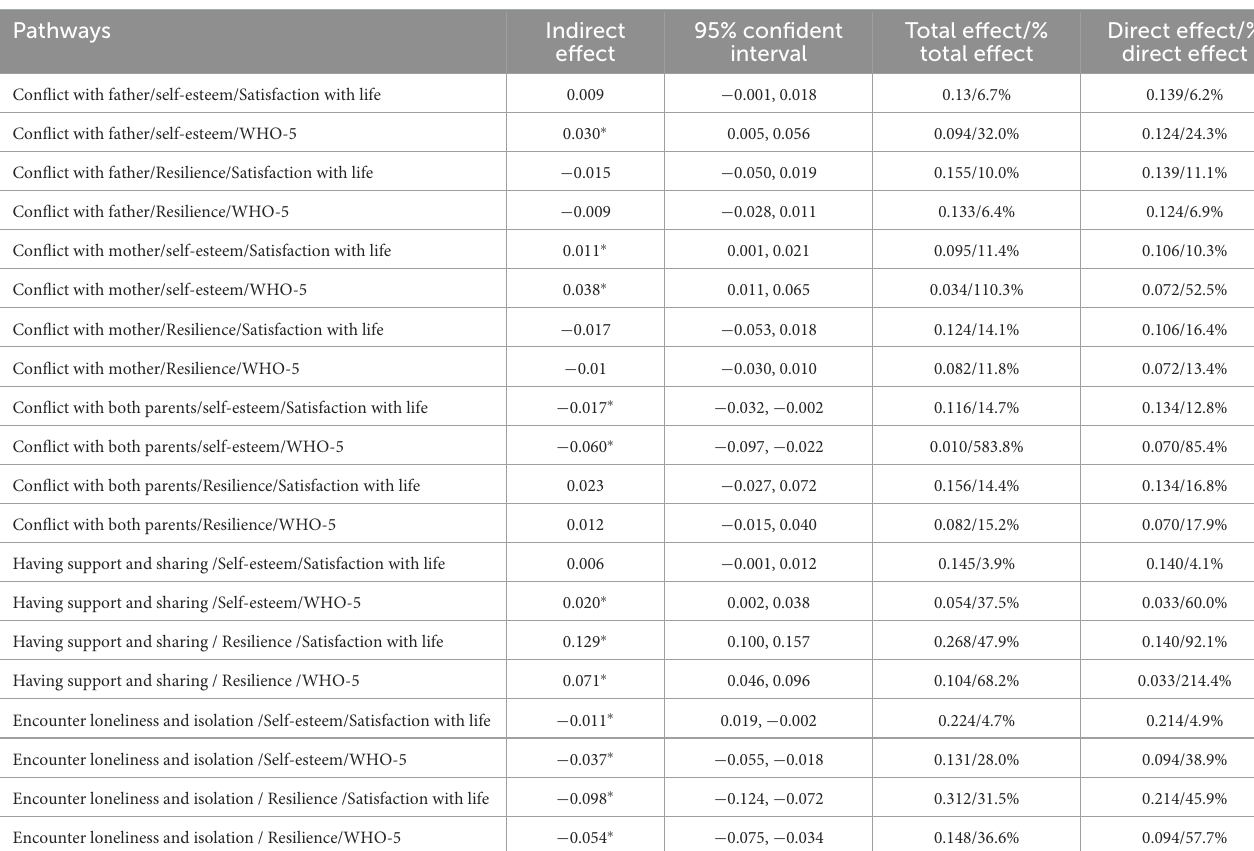
95% confident Total effect/% effect interval total